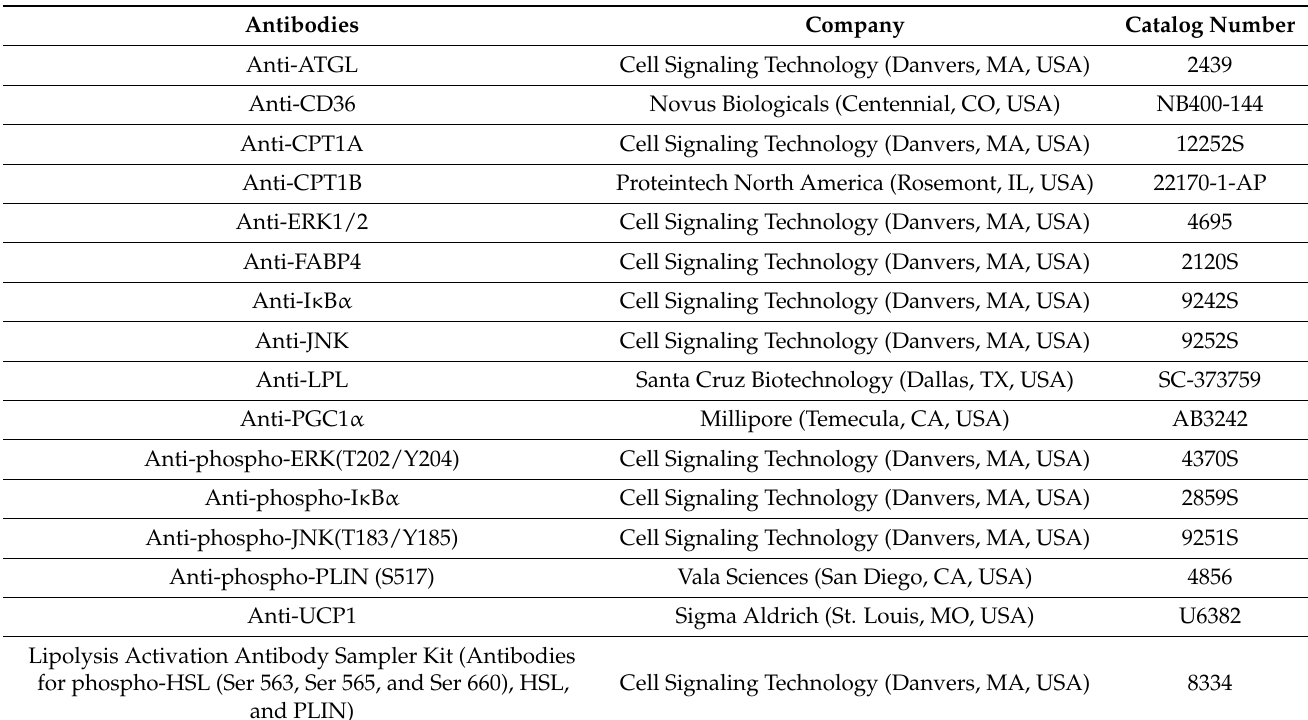
Table 1. Antibodies Used in the